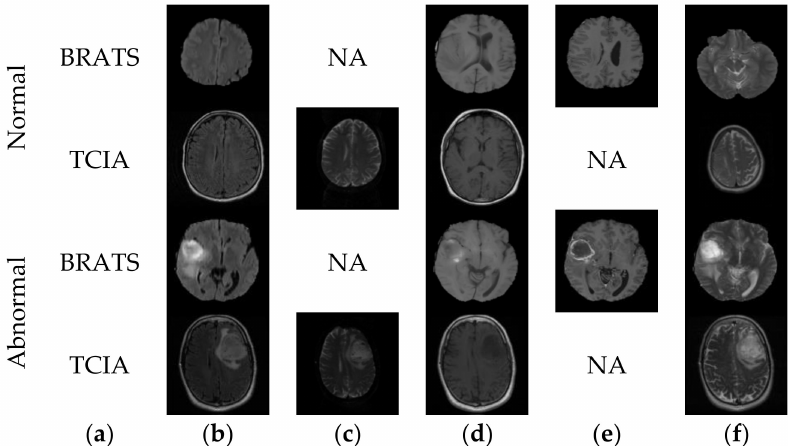
Figure 2. Sample test images with varied modalities. ( a ) Dataset employed, ( b ) Flair, ( c ) DW, ( d ) T1, ( e ) T1C and ( f ) T2.